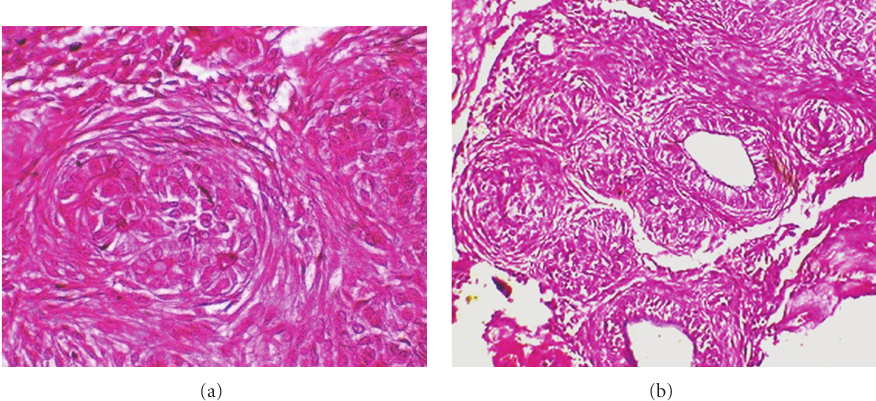
Figure 5: (a) Microscopic photograph showing tumor nodule composed of spindle-shaped or cuboidal epithelial cells forming rosette-like structures (H&E × 40). (b) Microscopic photograph showing duct-like structures of odontogenic epithelium lined by a single row of cuboidal or low columnar epithelial cells (H&E ×